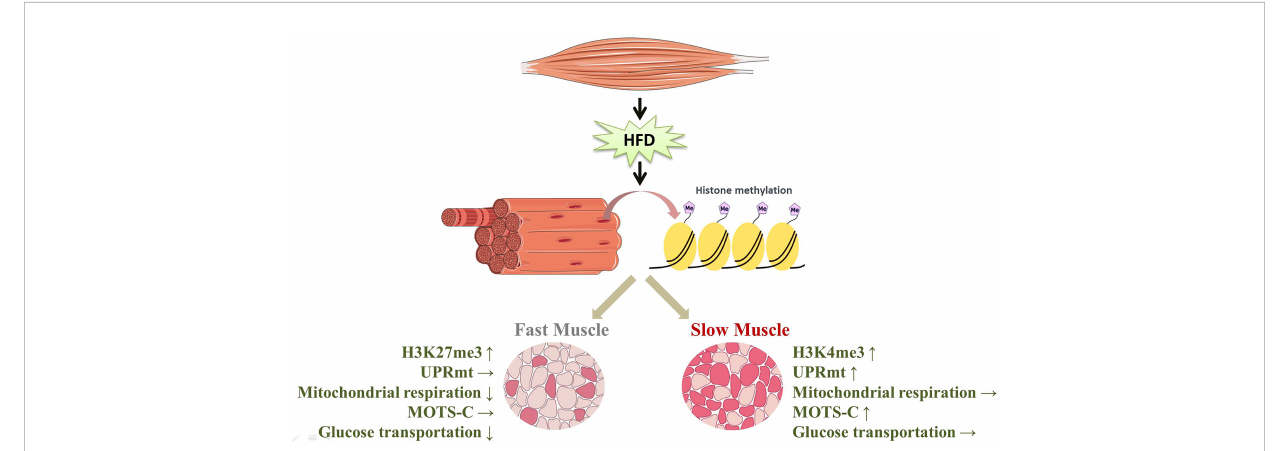
FIGURE 7 HFD induced the speci fi c activation of the UPRmt in slow- and fast-twitch muscles. ( ↑ , upregulation; ↓ , downregulation; ! , no